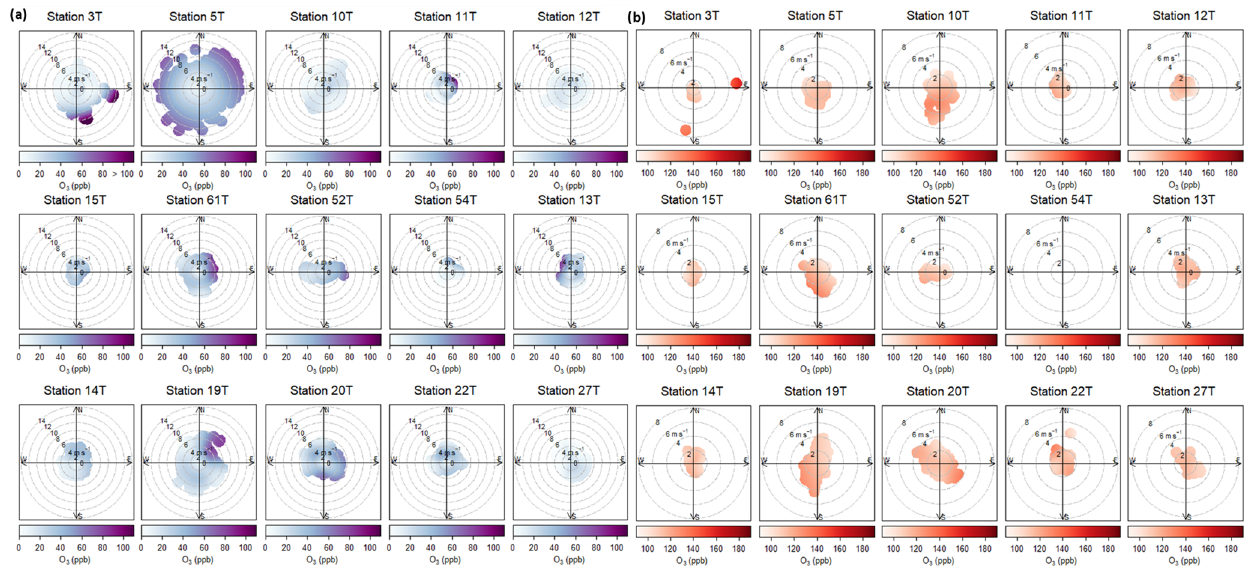
Figure 8. Relationship between the concentrations of O 3 , wind speeds and wind directions during (a) O 3 episodes ([O 3 ] hourly >100ppb) and (b) during non-O 3 -episodes ([O 3 ] hourly ≤ 100ppb) over BMR from 2010 to